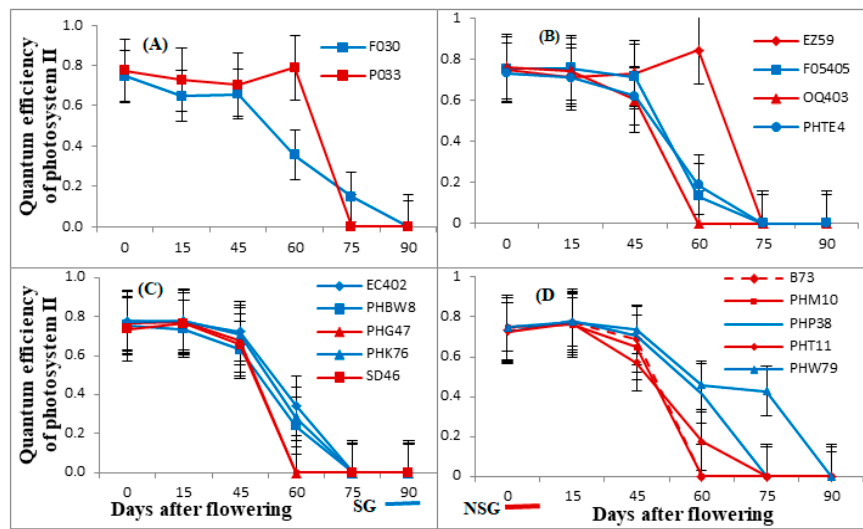
Figure 4. Quantum efficiency of photosystem II (Fv/Fm) from flowering time of 16 maize inbred lines of four flowering groups, evaluated in 2017 in two locations in Galicia, ( A , B , C , D ) present each flowering group: very early, early, medium, and late flowering, respectively; SG: stay-green genotype. NSG: non-stay-green; Means ± std error are presented.